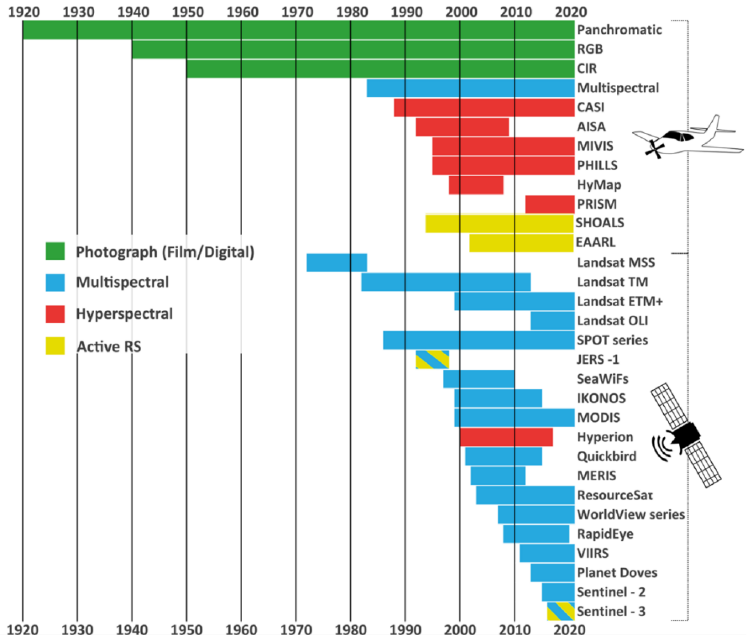
Figure 1. Operation chronology of a selection of remote sensors used in Submerged Aquatic Vege- tation (SAV) research by platform and sensor type.